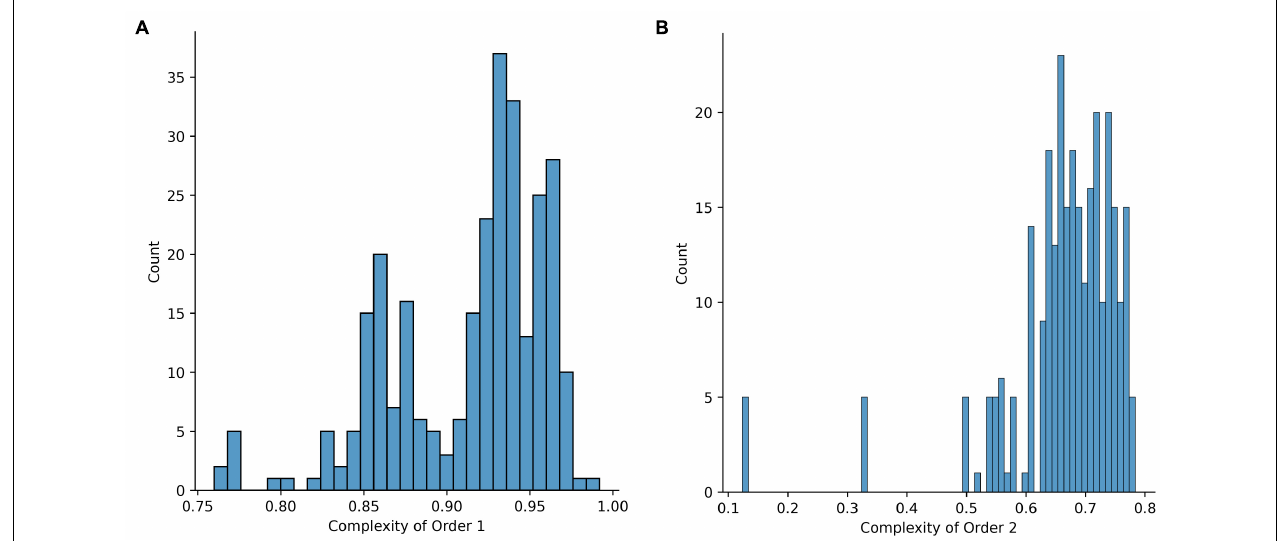
FIGURE 6 | Histograms of complexity of natural images. (A) Complexity of Order 1 (Equation 6). (B) Complexity of Order 2 (normalized version of Equation 7). We obtained the 286 images for these histograms from the UPenn Natural Image Database, using Albums cd06, cd09, cd12, cd15, and cd23 (Tkaˇcik et al., 2011), which contained no human-made objects. The histograms predominantly exhibit a rise-then-fall inverted-U-shape behavior. Only one notable exception to this behavior is observed in these histograms. Their gross behavior is more interesting than a simple inverted-U-shape, exhibiting a slight bimodality. This bimodality may indicate that images from different environments have dissimilar distributions of complexities. In support of this idea, the very low Complexities of Order 2 in (B) are due to some shots of cloudless